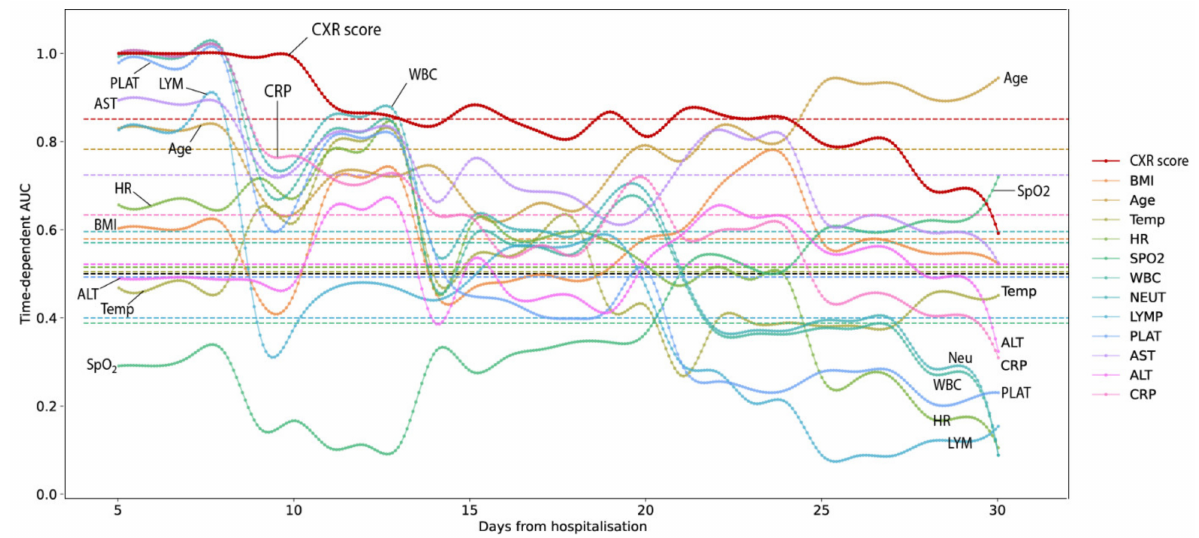
Figure 3. Time-dependent AUC for predicting death within 30 days among 13 clinical parameters, including CXR